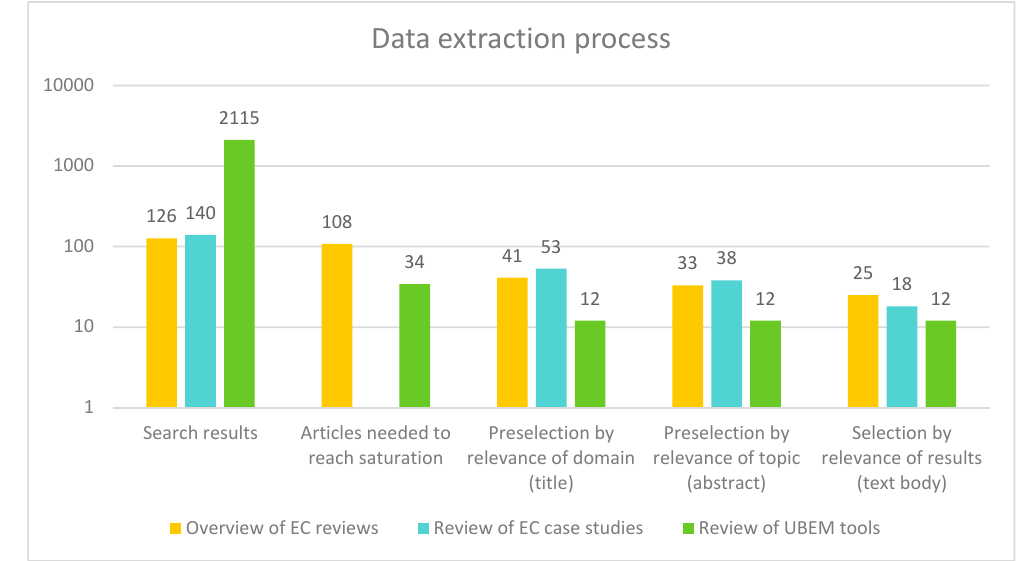
Figure 5. Selection process of references disaggregated to data sources.